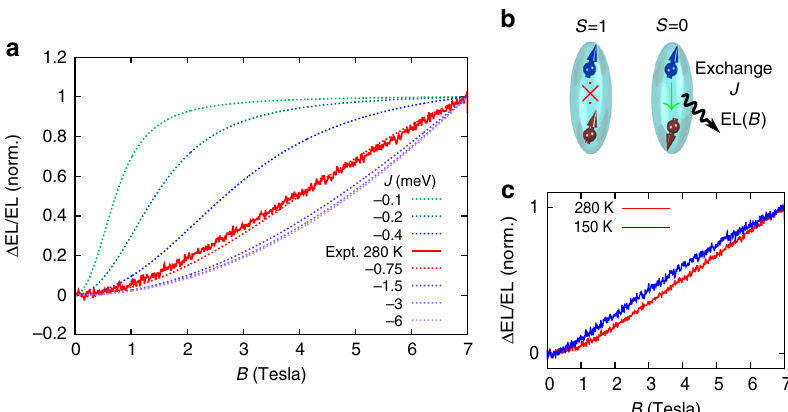
Fig. 5 Electron-hole spin-dependent recombination theory for the magneto-electroluminescence. Simulated magneto-electroluminescence using the model described in the text. Normalised simulations are shown in a for varying electron-hole exchange energy J alongside the experimental data at 300 K (a comparison between normalised 300 and 150 K data is shown in c ). The characteristic saturation fi eld of the magneto-electroluminescence is determined by the electron-hole exchange energy. Fitting to the 300 K experimental data gives an exchange energy J = − 0.75 meV. Panel b illustrates the singlet and triplet spin pairings of a weakly bound electron/hole pair for which only the singlet state